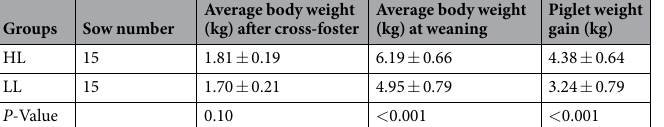
Table 4. Lactation performance of sows in HL and LL groups. HL: High lactation performance group; LL: low lactation performance group; Piglet weight gain = Average body weight at weaning - Average body weight after